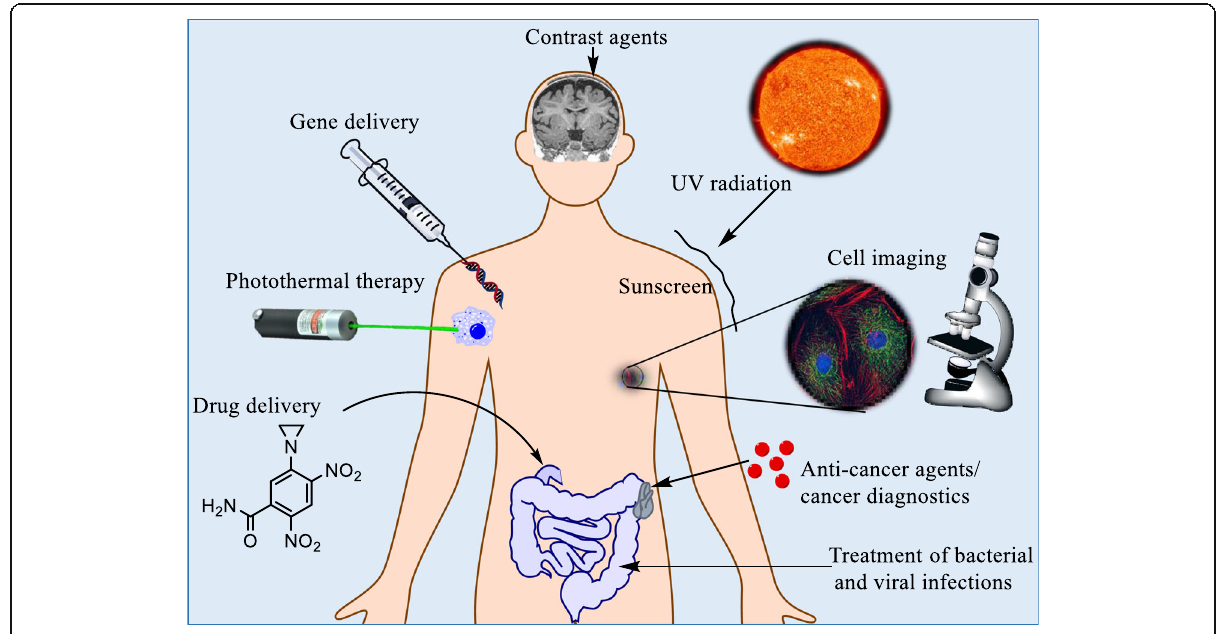
Fig. 1 Some of the current uses of nanoparticles in